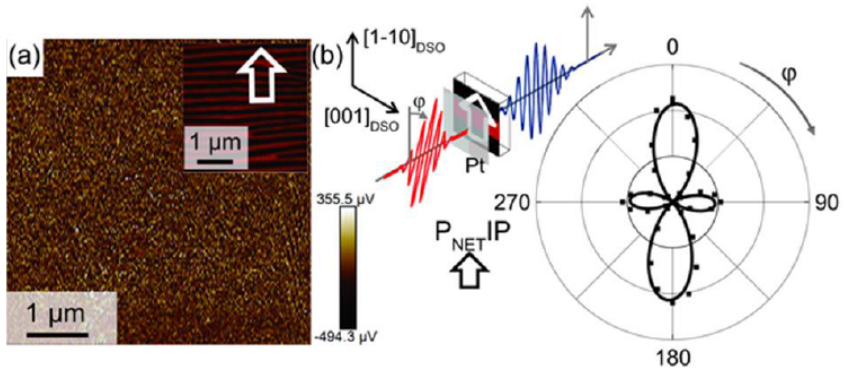
Figure 14. Ferroelectric domain structure in a BFO thin film on La 0.7 Sr 0.3 MnO 3 buffered DSO capped with 4 nm Pt. ( a ) PFM image of the Pt-capped BFO shows no ferroelectric domain contrast. For comparison, the inset shows the domain structure of the uncapped BFO layer. ( b ) SHG polarizer measurement identifies a polar axis along the vertical orientation, corresponding to the macroscopic net polarization direction, indicated by the white arrows in the insets of ( a , b ). Reproduced with permission from [88], Copyright Wiley-VCH Verlag GmbH and Co. KGaA,